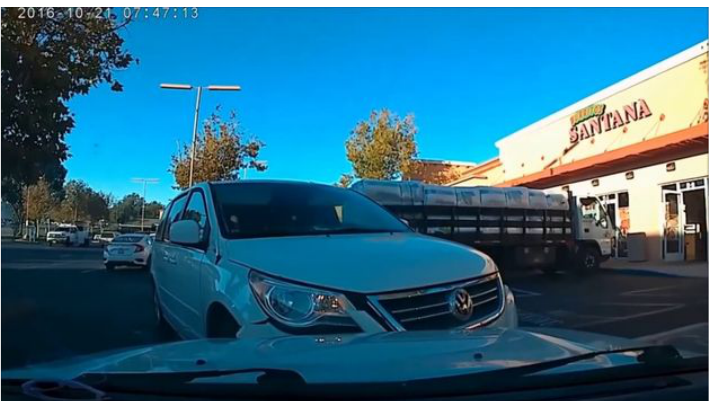
Figure 3. Example of one of the head-on crash images obtained after the extraction and the resiz- ing